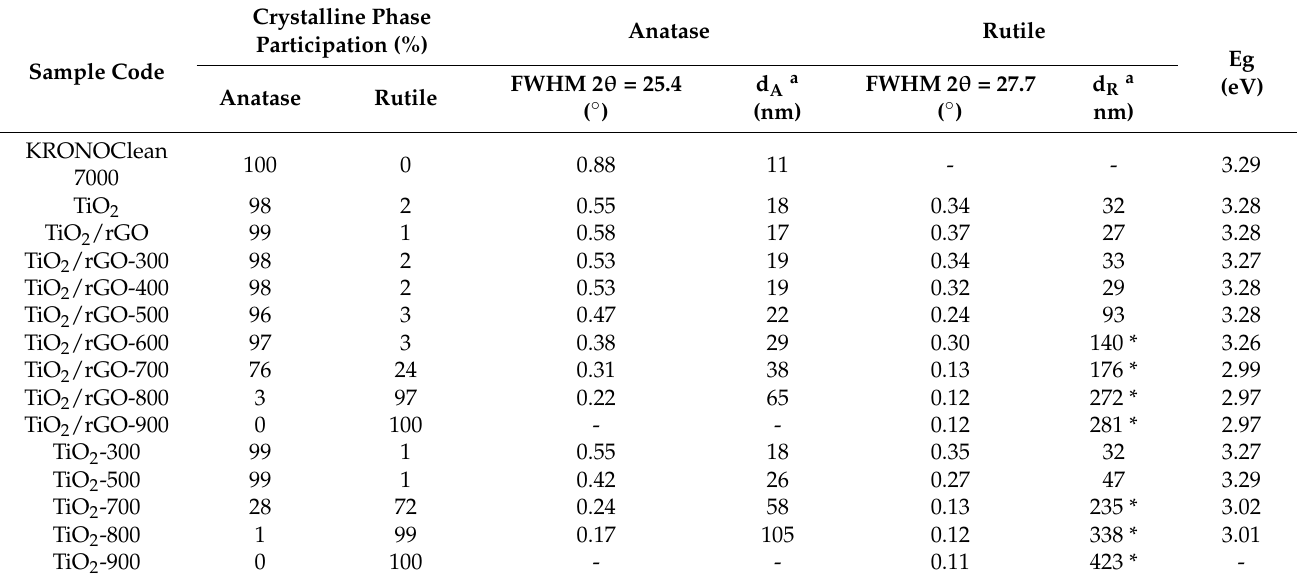
Table 1. XRD phase compositions and crystallite sizes for reference, control, and obtained photocatalysts.